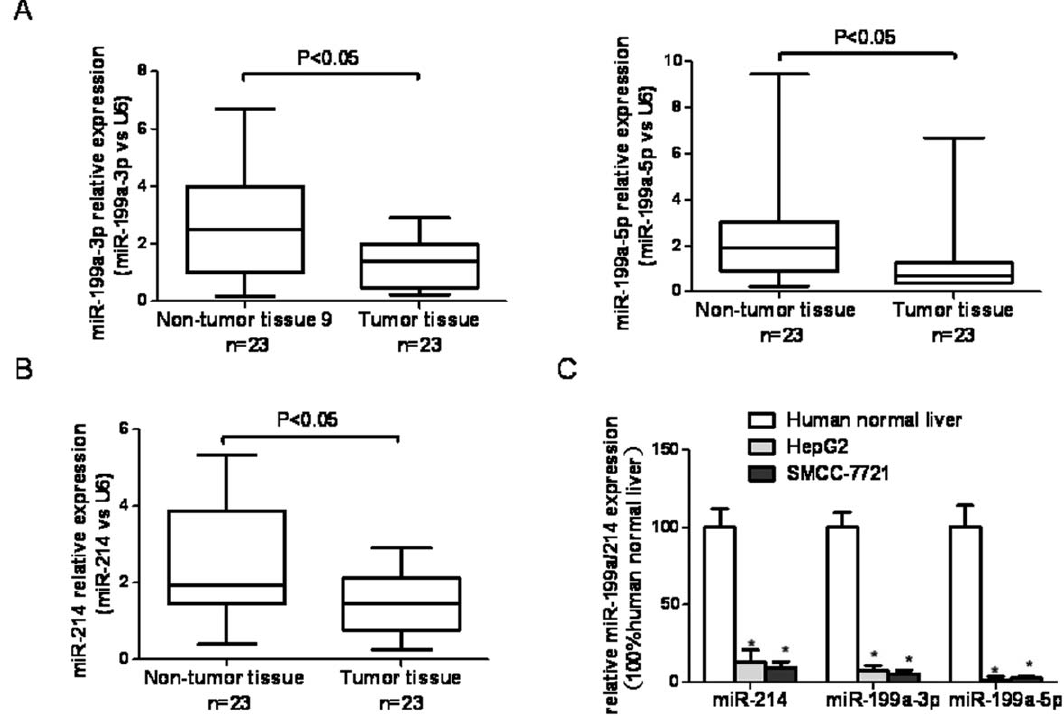
Figure 1. miR-199a/214 expression in HCC samples and cell lines. ( A ) Box plot graphic displays of 23 HCC and matched adjacent benign tissues grouped according to miR-199a-3p and miR-199a-5p expression. ( B ) Box plot graphic displays of 23 HCC and matched adjacent benign tissues grouped according to miR-214 expression. ( C ) miR-199a/b-3p and miR-214 expression in human normal liver, HepG2, and SMMC-7721 HCC cell lines was detected using real-time qRT-PCR. Columns, mean of three independent experiments; bars, SD; * P , 0.05 vs control.